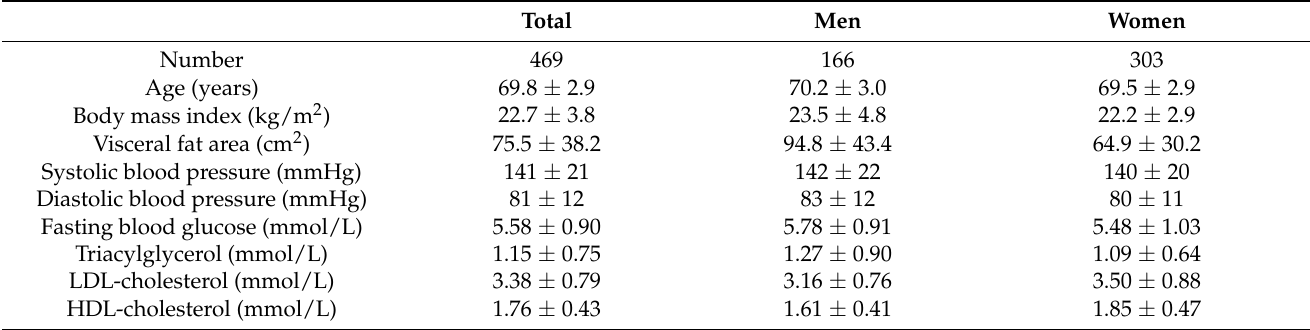
Table 1. Physiological characteristics of the older Japanese adults living in urban areas.